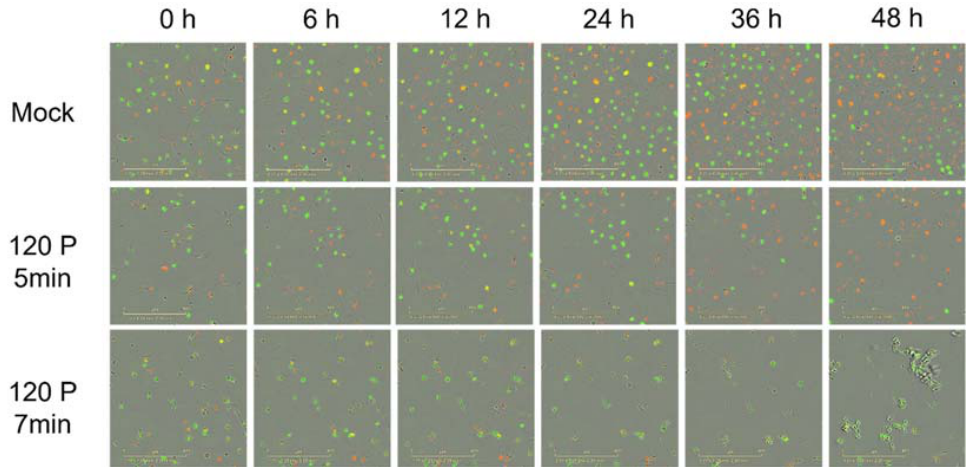
Figure 4. Representative IncuCyte images showing mock control and CHCP-treated cells in G1 (green), S/G2/M (red) and G2-S (yellow) phases over 48 h. Mock control had a relatively even population distribution of all cell cycle phases. Cells treated with 120 P for 5 min arrested in S/G2/M (6 h) before recovering (24-36 h). Cells treated with 120 P for 7 min immediately arrested in S/G2/M (0–6 h) before shrinking (12 h) and undergoing apoptosis (24 h), eventually resulting in zero visible live cells (36–48 h).